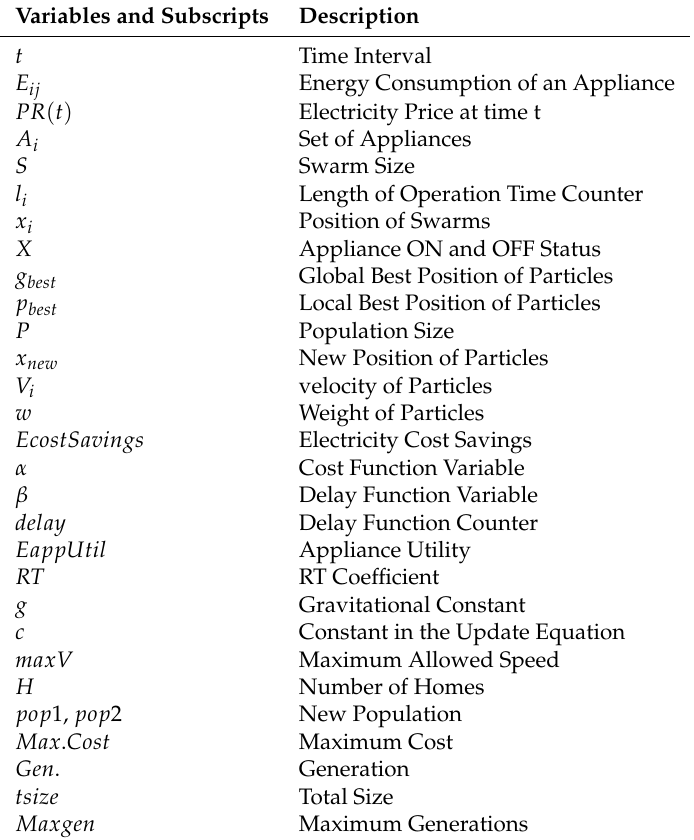
Table 1. Nomenclature.